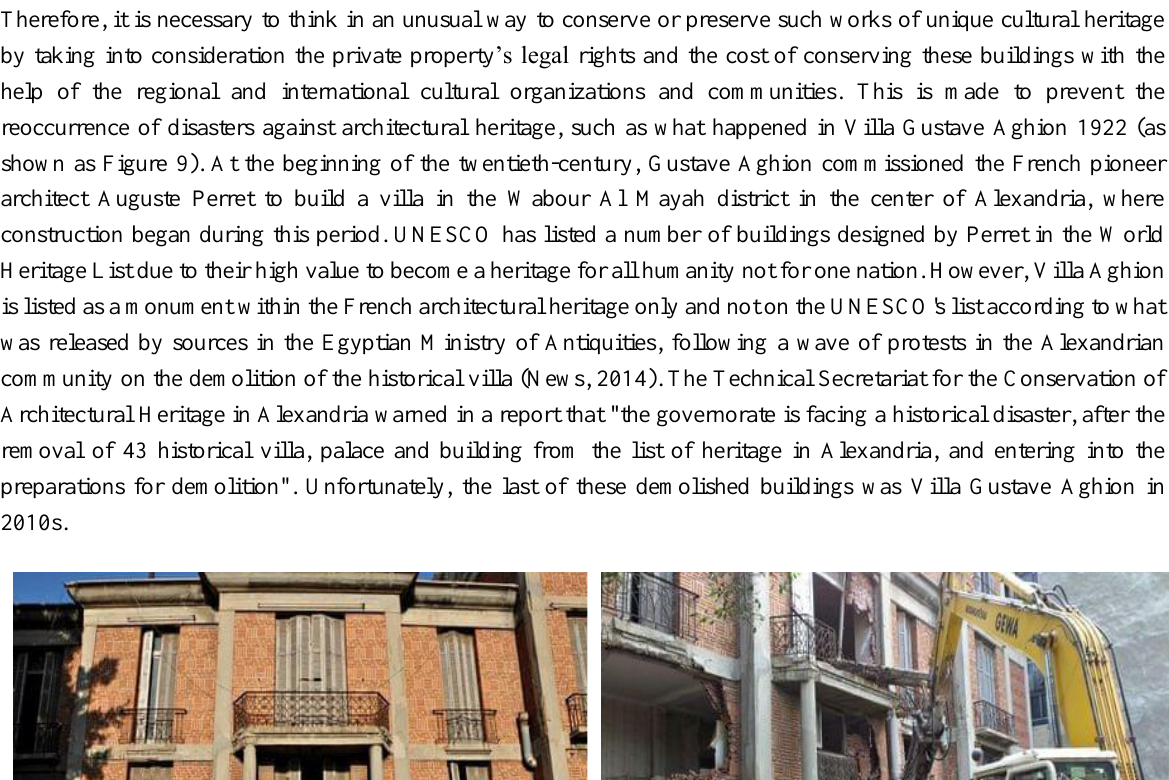
Figure 8: Villa Checorail, Ahmed Shawki Street; Roshdy - Alexandria (El Mwatin Newspaper, 2016)